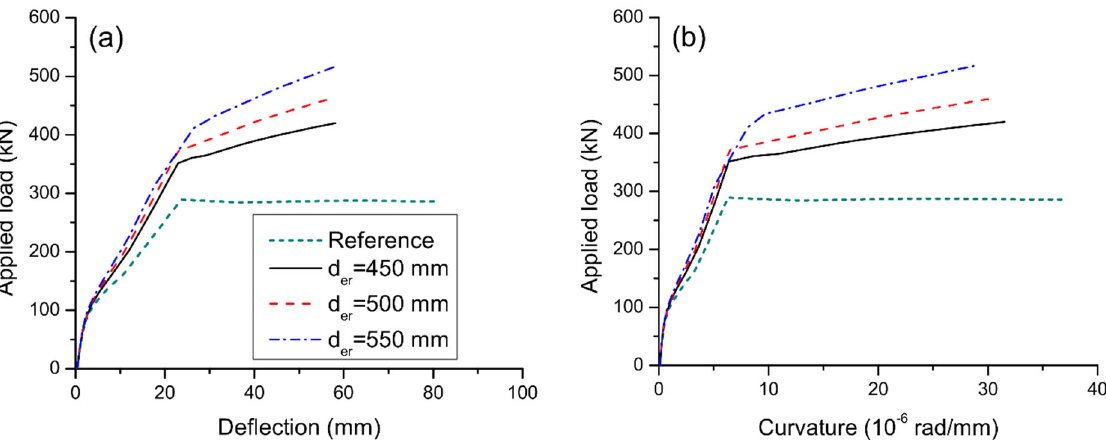
Figure 12. Effect of reinforcement depth on the deformation at midspan. ( a ) deflection development; ( b ) curvature development.